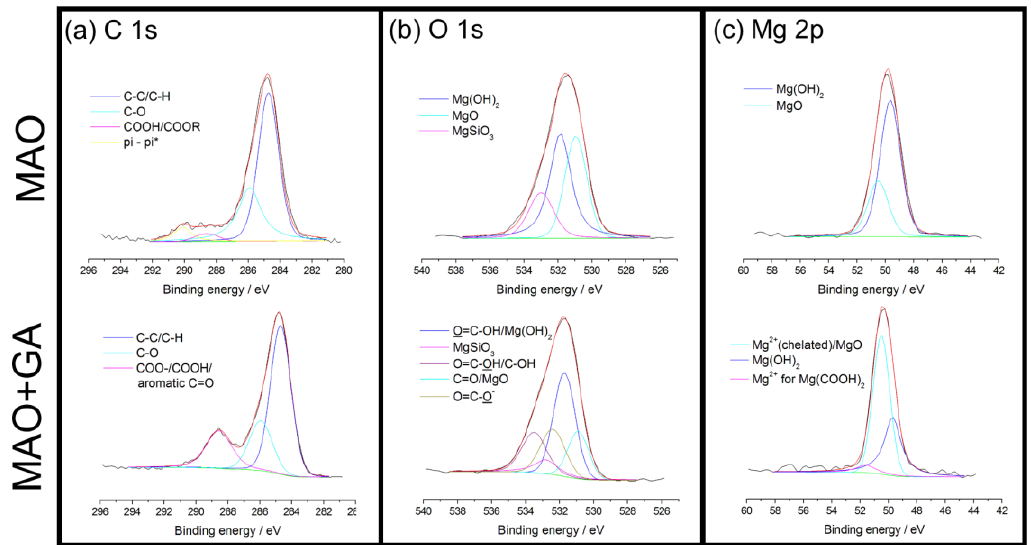
Figure 4. ( a ) C 1s; ( b ) O 1s, and ( c ) Mg 2p spectra of MAO and MAO+GA coating.